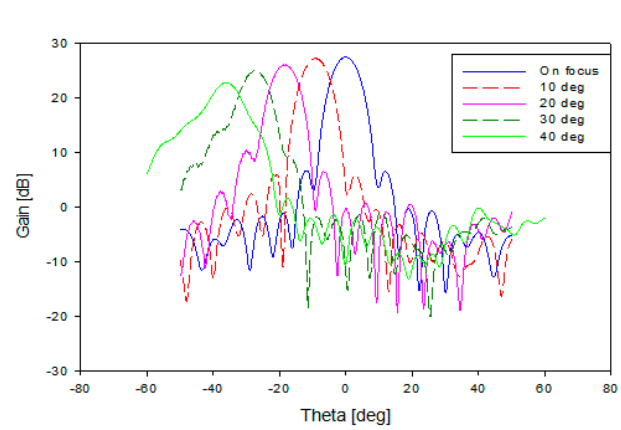
Figure 19. Feed position arrangement.